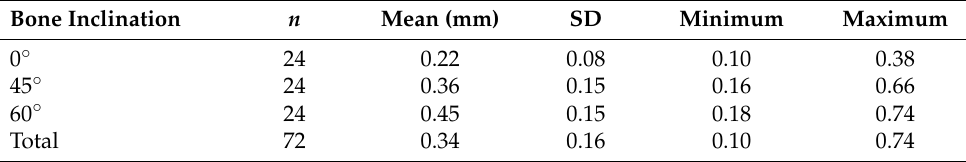
Table 11. Results of descriptive statistics of lateral linear deviation in varying bone inclinations.